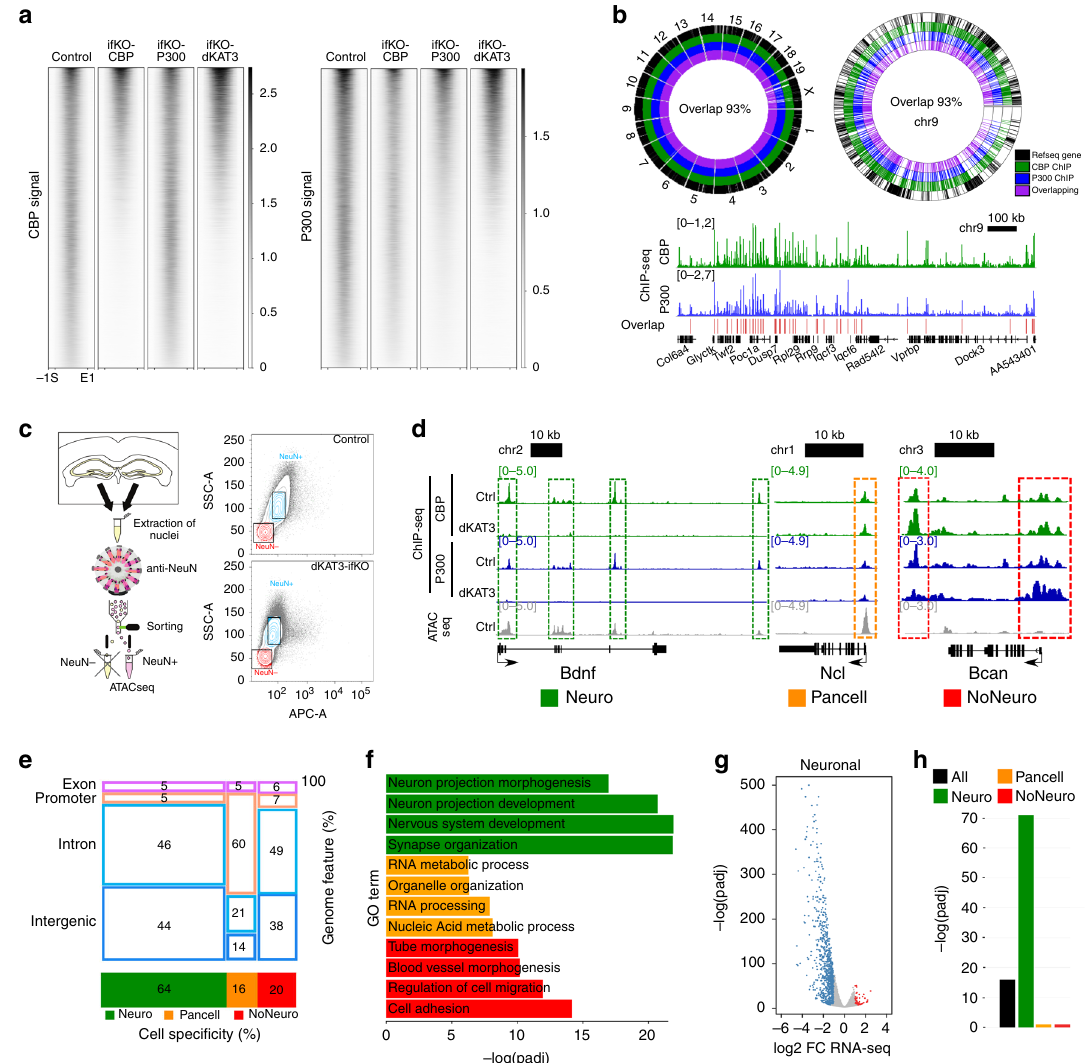
Fig. 4 CBP and p300 bind to the same genomic sites. a Heat maps showing the control CBP/P300 KAT3 ChIP-seq peaks and the signal in the corresponding locations of CBP-, p300-, and KAT3-ifKO. Intensity ranges from strong (black) to weak (white). S: peak start, E: peak end, ±1 kb. b Circos plots of the entire genome (left) and chromosome 9 (right). Below: a snapshot of a gene-rich region in chromosome 9. Colors indicate CBP and p300 binding in hippocampal chromatin and their overlap. Refseq genes in black. c Left: scheme of the FANS/ATAC-seq experiment. Right: fl ow cytometry sorting plots for control and dKAT3-fKO samples. Boxes indicate the gates used for sorting NeuN + nuclei (blue). APC-A is the signal of anti-NeuN staining. d Snapshot illustrating the classi fi cation of KAT3 peaks in neuronal (green), non-neuronal (red), and pancellular (orange). Representative peaks classi fi ed as neuronal, non-neuronal, and pancellular are marked with a green, red, and orange dashed rectangle, respectively. e Classi fi cation of KAT3 peaks according to cell speci fi city (neuronal, pancellular, and non-neuronal) and genomic features (promoter, exon, intron, intergenic). The numbers within each sector represent percentages. f GO enrichment analysis performed on the gene sets associated with neuronal (green), non-neuronal (red), and pancellular (orange) KAT3 peaks. g Volcano plots of RNA-seq analysis for the subset of genes classi fi ed as neuronal. Red: upregulated genes; blue: downregulated genes. h BETA analysis of the association between all, neuronal, non-neuronal, and pancellular KAT3 peaks, and transcriptome changes. Neuronal peaks show the strongest association with gene downregulation. p -Values in Kolmogorov – Smirnov test using BETA-cistrome software: p -val All = 6.24e − 17; p -val Neuro = 3.34e − 72; p -val NoNeuro = 0.3; p -val Pancell = Other cell type fates also require KAT3 proteins . Previous digital footprints in DARs and detected robust differences (Fig. 5k studies have shown that KAT3 proteins play a critical role in the and Supplementary Fig. 12c), con fi rming that some changes in differentiation of several cell types and the establishment of cell- chromatin occupancy re fl ect the reduced binding of members of type-speci fi c transcription 30 – 33 . To investigate if cell fate main- this family. This fi nding is consistent with the large overlap tenance in other cell types also requires the KAT3 activity, we between bHLH TF footprints detected in the ATAC-seq pro fi les next examined astrocytes derived from dKAT3- fl oxed mice and Neurod2 ChIP-seq data 29 (Supplementary Fig. 12d). Alto- (Fig. 6a). We prepared astrocyte cultures from the hippocampi of gether these experiments indicate that CBP and p300 interact Crebbp f/f ::Ep300 f/f embryos and infected them with a Cre- with bHLH proneural TFs in neuronal-speci fi c genomic locations to maintain neuron-speci fi c transcription (Fig. 5l and Supple- recombinase-expressing lentivirus. Similar to our results in neu- mentary Fig. 12e show some representative examples). rons, primary cultures of cortical astrocytes missing both KAT3